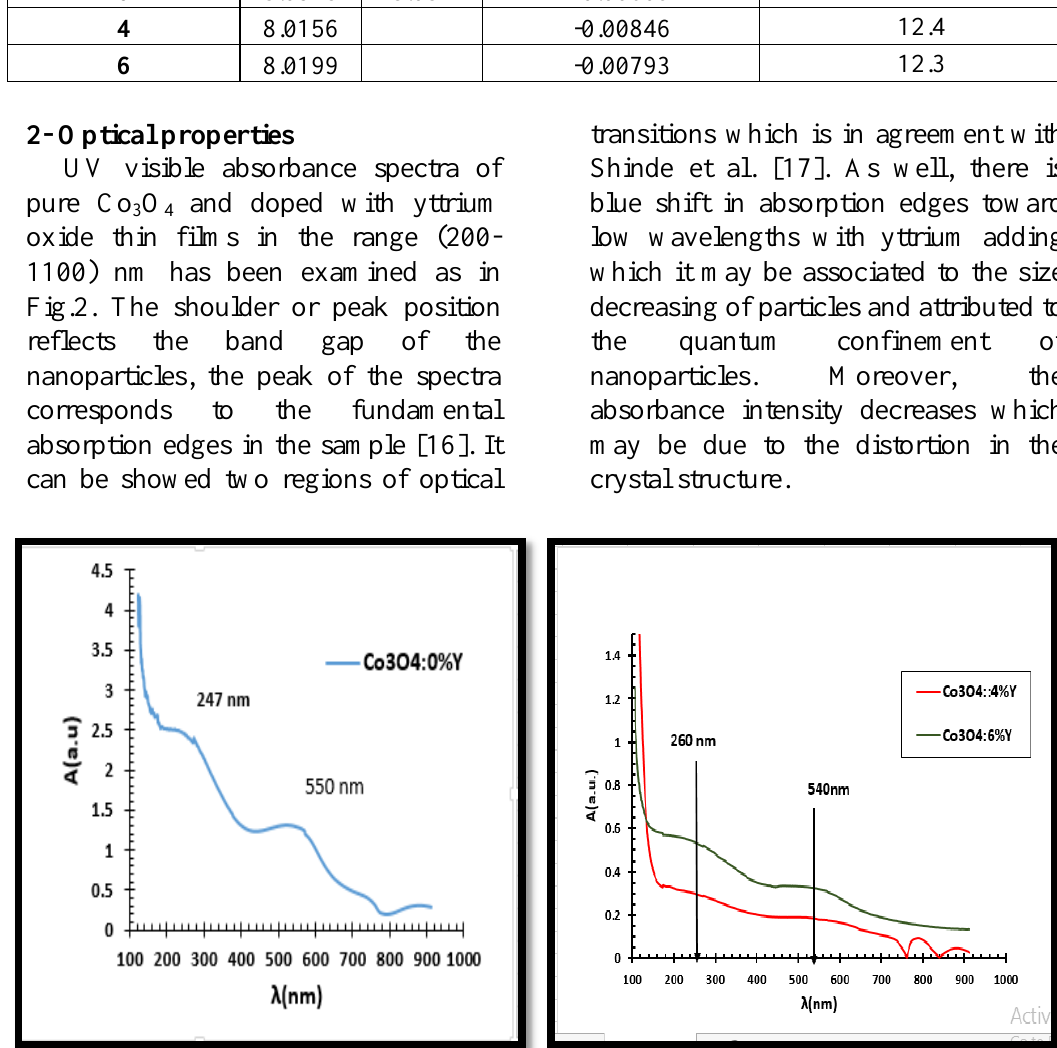
Table 2: Lattice constant, strain and Crystallite size for pure Co Doping ratio %